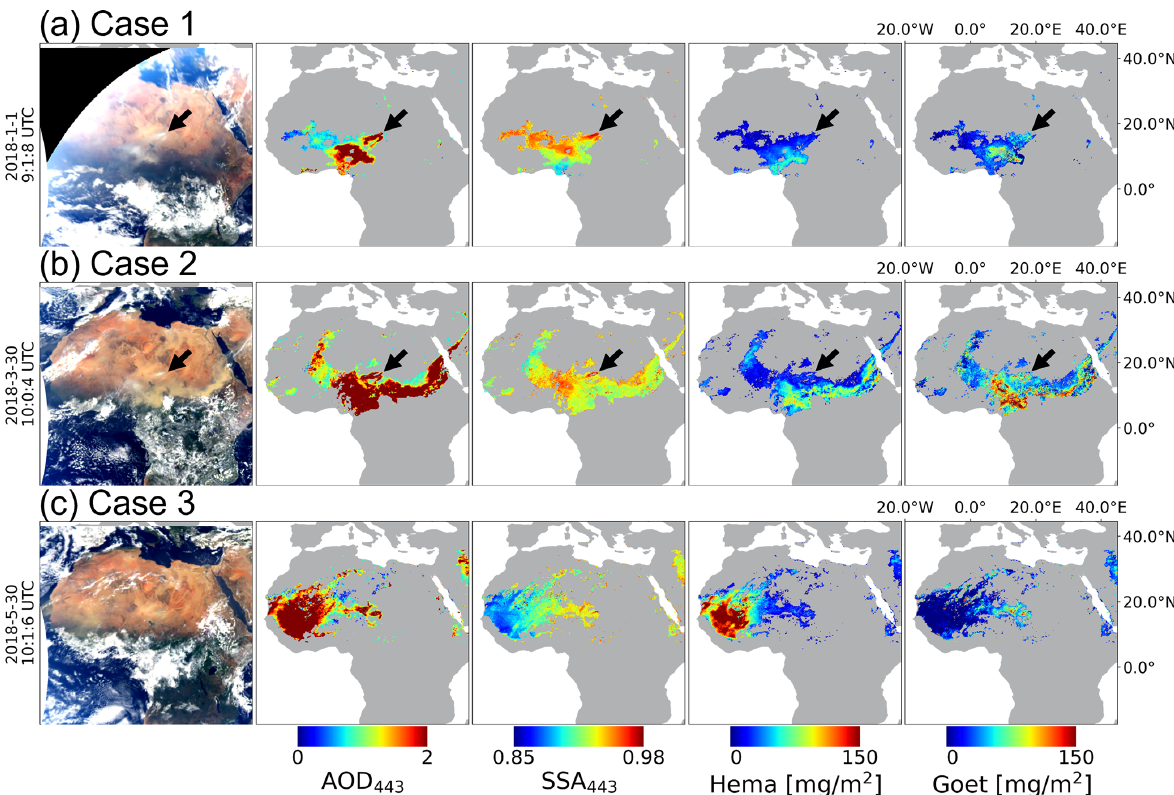
Figure 5. Dust episodes over Sahara–Sahel region. From left, RGB TOA image generated from EPIC L1B version 3 data, MAIAC AOD and SSA at 443nm, and hematite and goethite mass concentrations for 1 January 2018 (a) , 30 March 2018 (b) , and 30 May 2018 (c) . The black arrows point to the Bodélé Depression